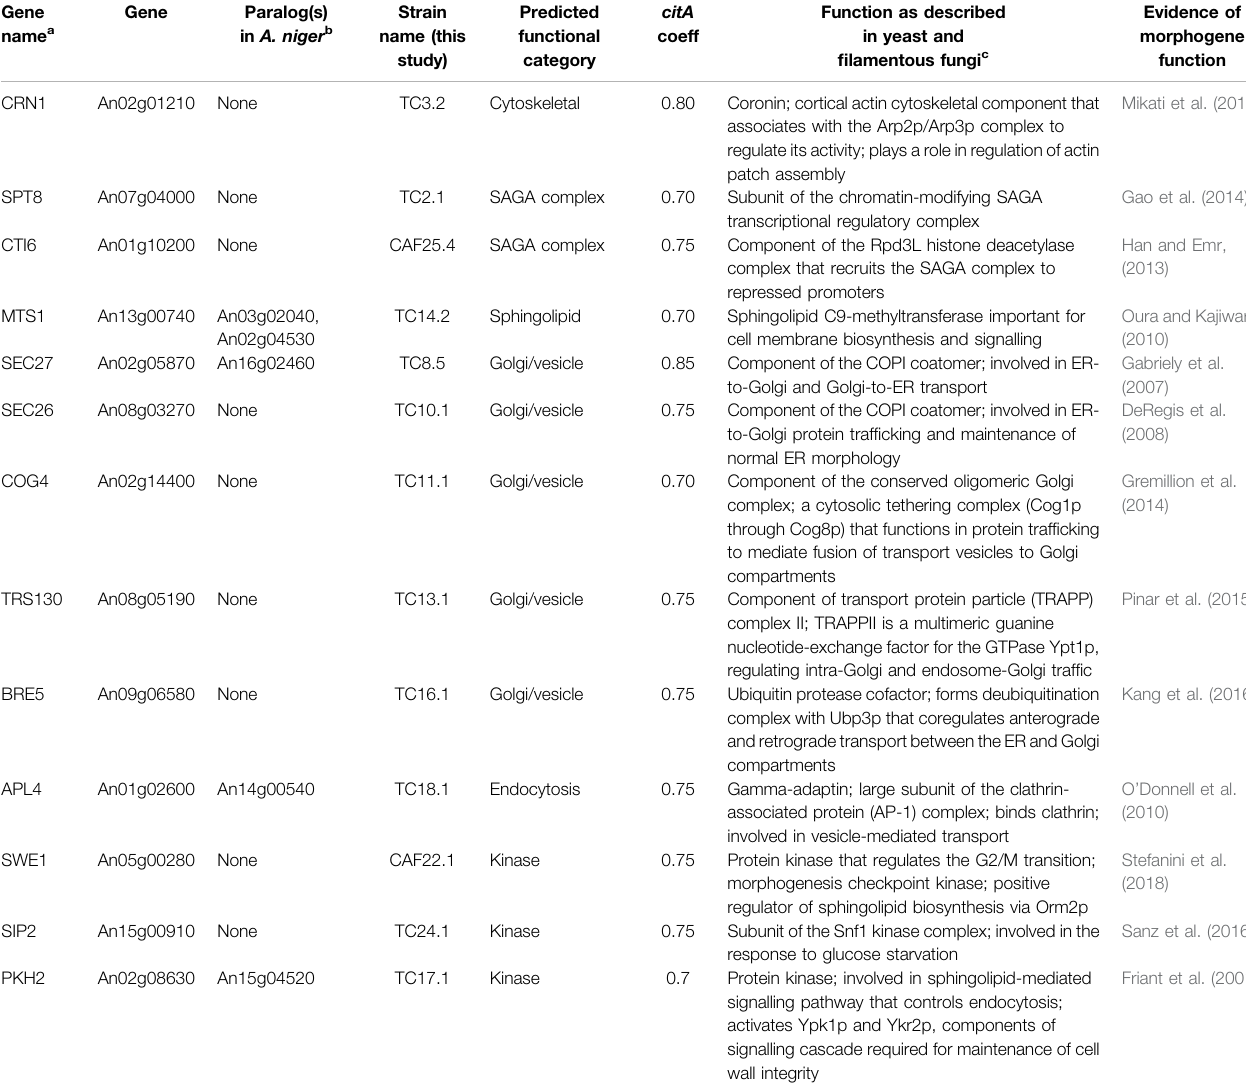
TABLE 1 | Strains and corresponding morphogenes characterized in this study. Morphogenes were divided into six categories based on their predicted function. citA coef fi cients give correlation values relative between this gene and the respective